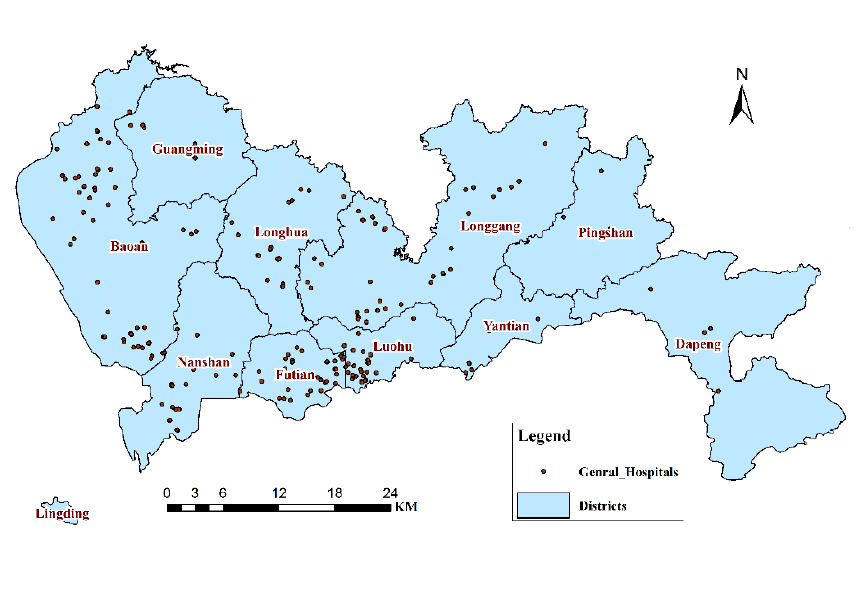
Figure 3. Distribution map of general hospitals in Shenzhen,